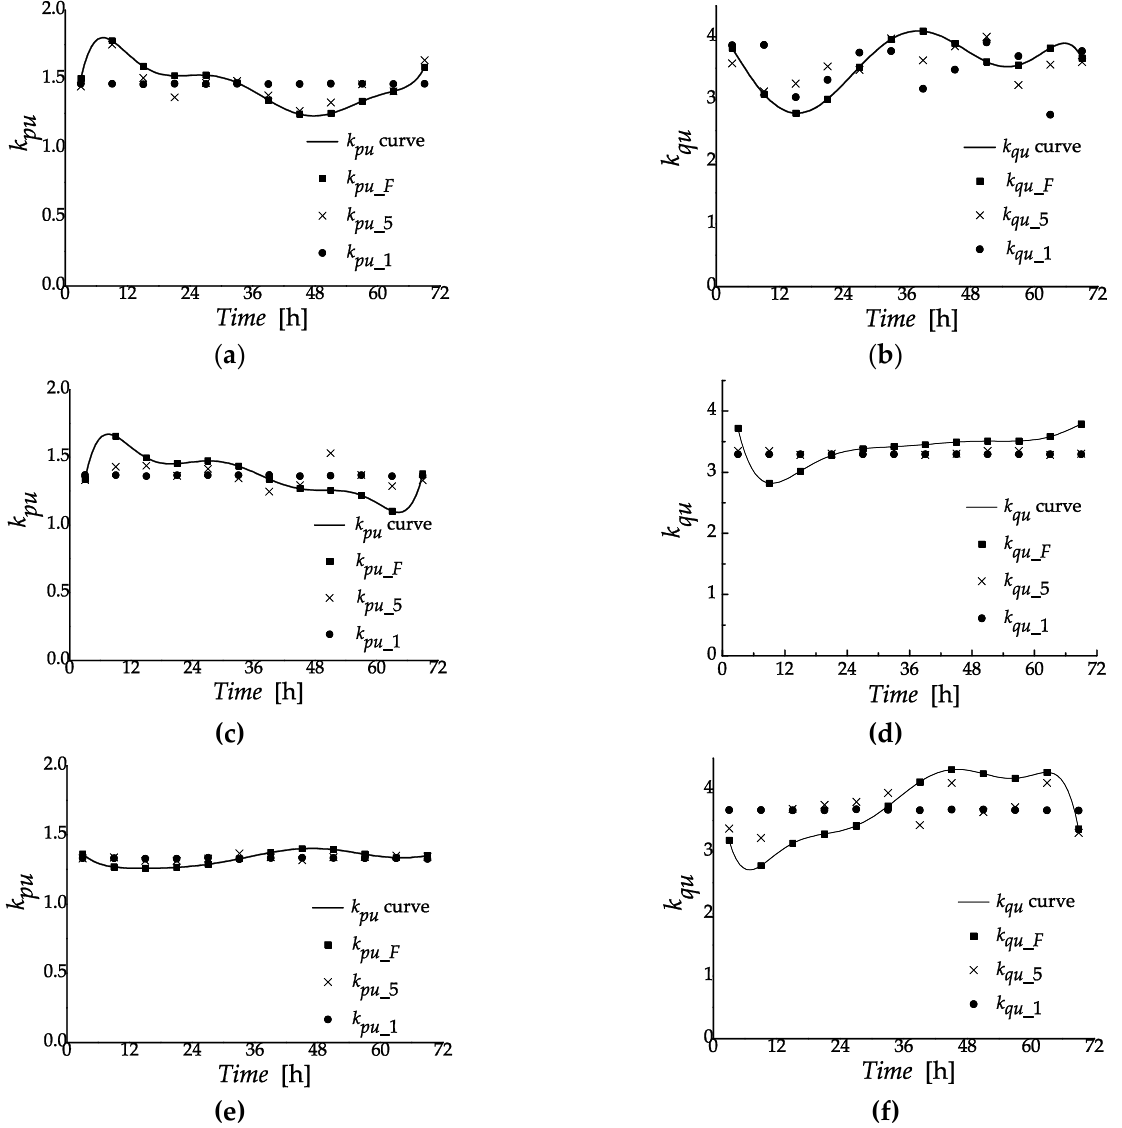
Figure 2. Fitting curves of k pu and k qu with the corresponding values ( k pu_F and k qu_F ) in three characteristic days obtained by using electrical variables, and k pu and k qu obtained by using five ( k pu_ 5 and k qu_ 5 ) and one ( k pu_ 1 and k qu_ 1 ) meteorological variable, in ( a , b ) winter; ( c , d ) spring/autumn; ( e , f ) summer.